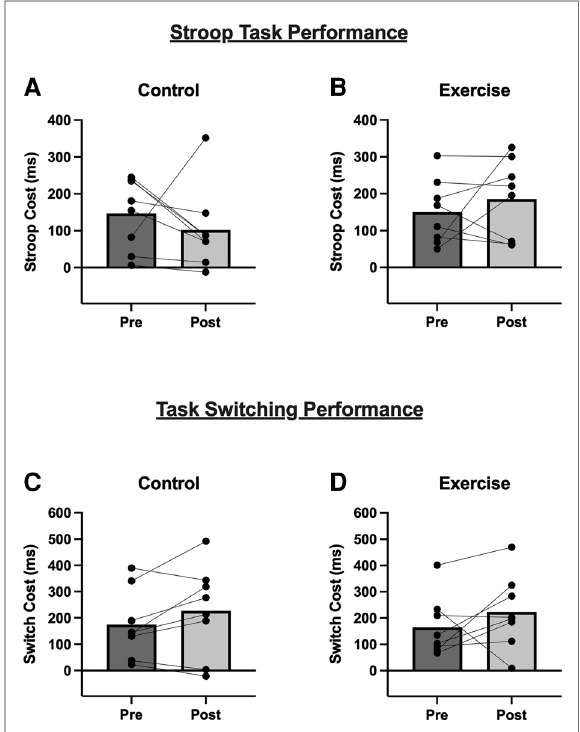
FIGURE 3 Stroop Task and Task-Switching performance before and 10- minutes after the ( A,C ) Control condition, and ( B,D ) acute exercise. For both outcomes, a lower score (i.e., lower cost) indicates better performance. Bars are group mean data and line-connected dots are individual responses within each